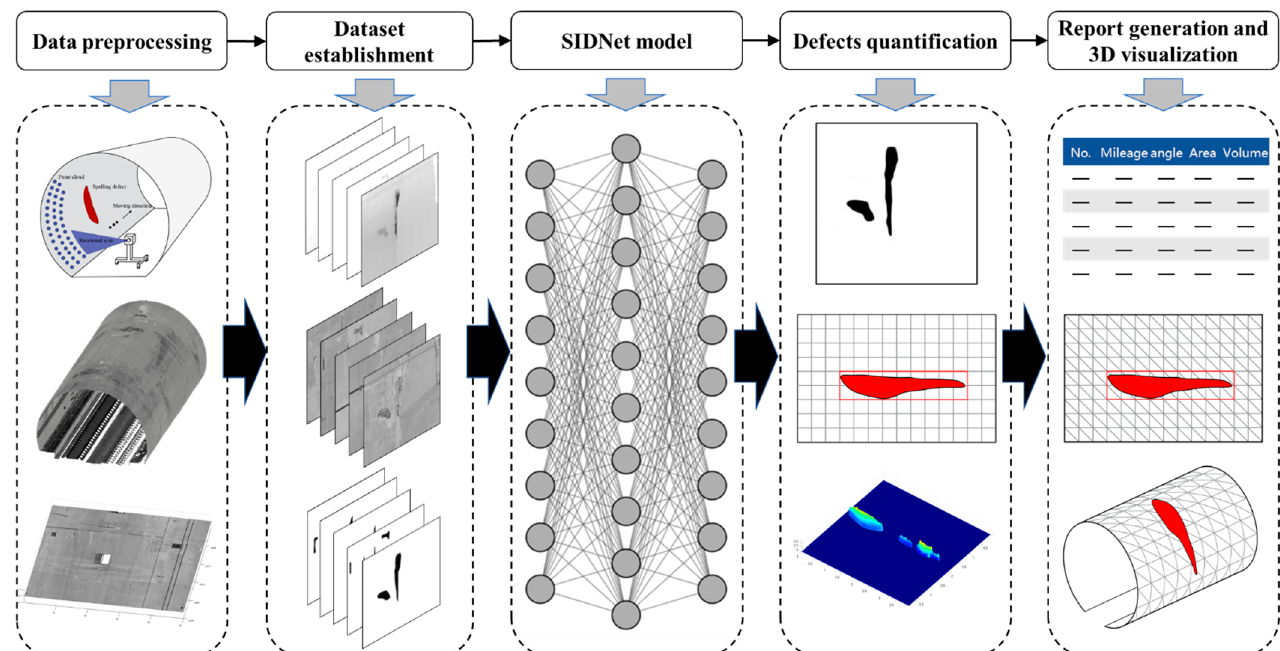
Figure 1. Schematic workflow of the proposed method for spalling defects inspection.